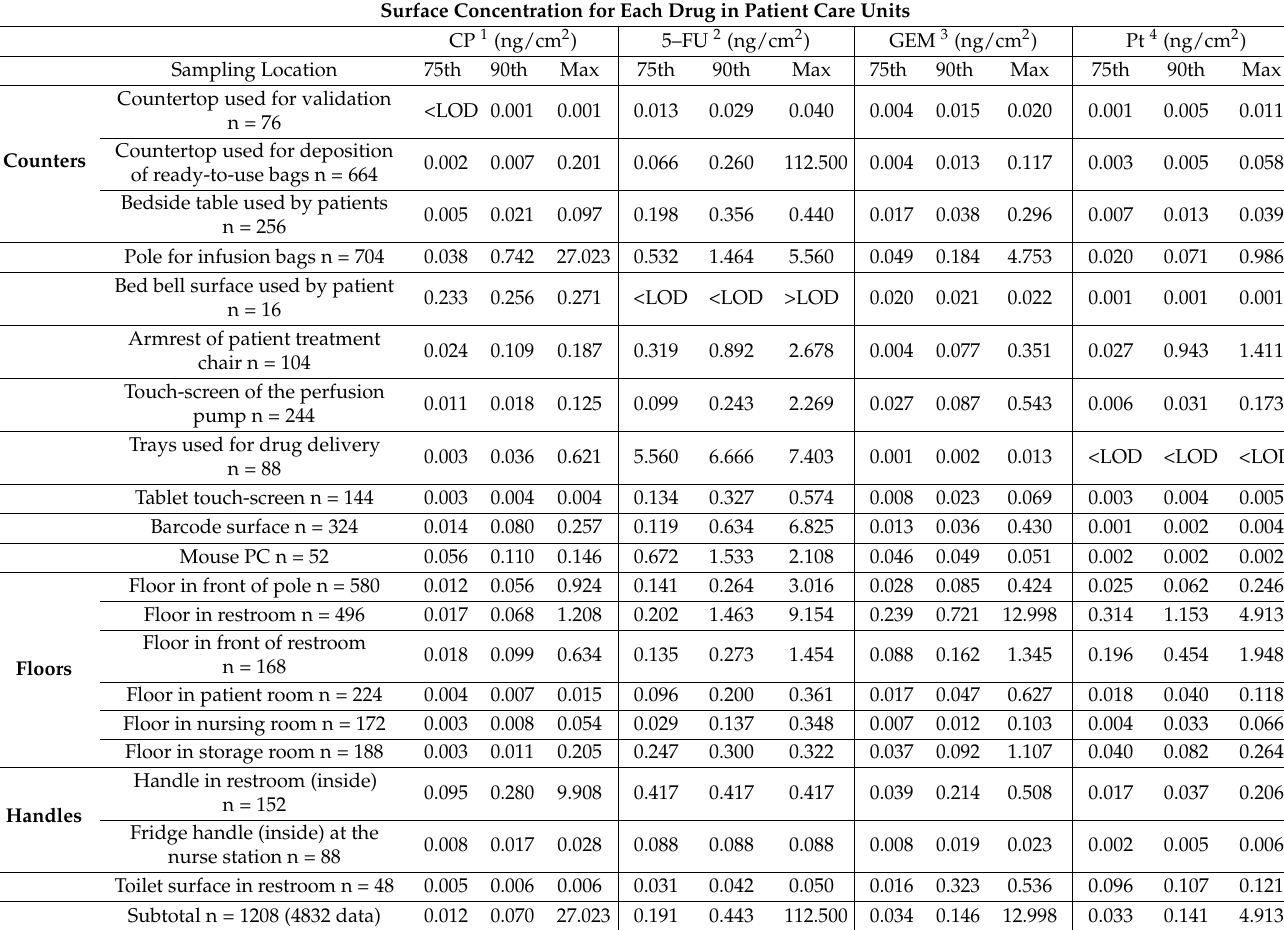
Table 5. Surface contamination reported as the 75th percentile, the 90th percentile, and the maximum value for each drug over the 5-year survey in wipe samples. Surface Concentration for Each Drug in Patient Care Units CP 1 (ng/cm 2 ) 5–FU 2 (ng/cm 2 ) GEM 3 (ng/cm 2 ) Pt 4 (ng/cm 2